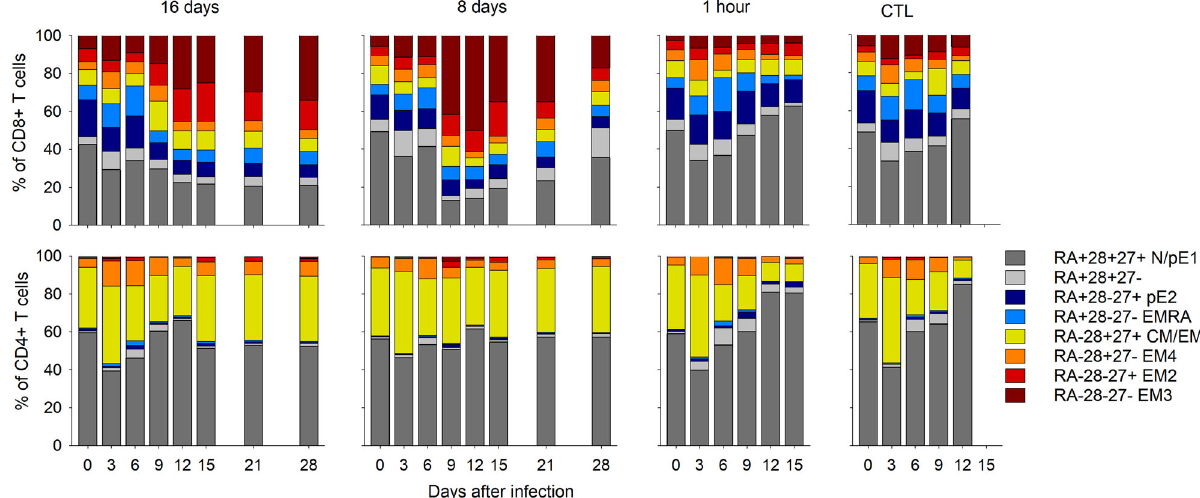
Fig. 7 | Evolution of memory cell subpopulations during the course of LASV infection. ProportionsofmemorycellsubpopulationsamongCD8 + (upperpanels) and CD4 + (lower panels) T cells in D-16, D-8, H+1,and CT animals according to the